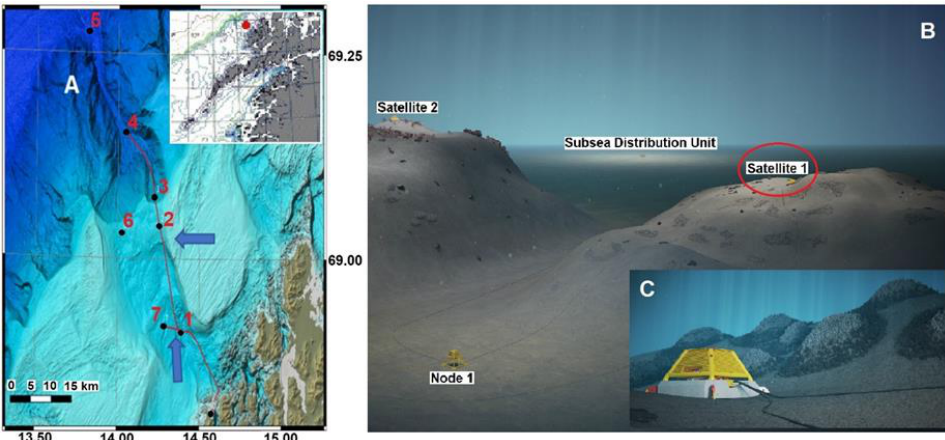
Figure 1. Overview of the study area where the Lofoten-Vesterålen (LoVe) observatory is located. ( A ) The bathymetric map of the canyon area with the extended cabled transect with the nodes (black dots) numbered 1–7 and connected by a telecommunication cable (continuous line). Node 1 is located in the deeper part of the trough (marked with southernmost blue arrow). This is a central location for Lophelia reef mounds. The new Autonomous Robotic Sea-Floor Infrastructure for Bentho-Pelagic Monitoring (ARIM) test platform will be located at node 2 (northernmost blue arrow). ( B ) A three-dimensional (3D) detailed representation of the area around node 1, where the satellite X-frame with video camera is encircled (in red). Here we collected the footage used to establish the artificial intelligence (AI) procedures for later transfer into the crawler for on-board image autonomous processing. ( C ) Enlarged view of the areas surrounding the node where Lophelia reefs are schematized.